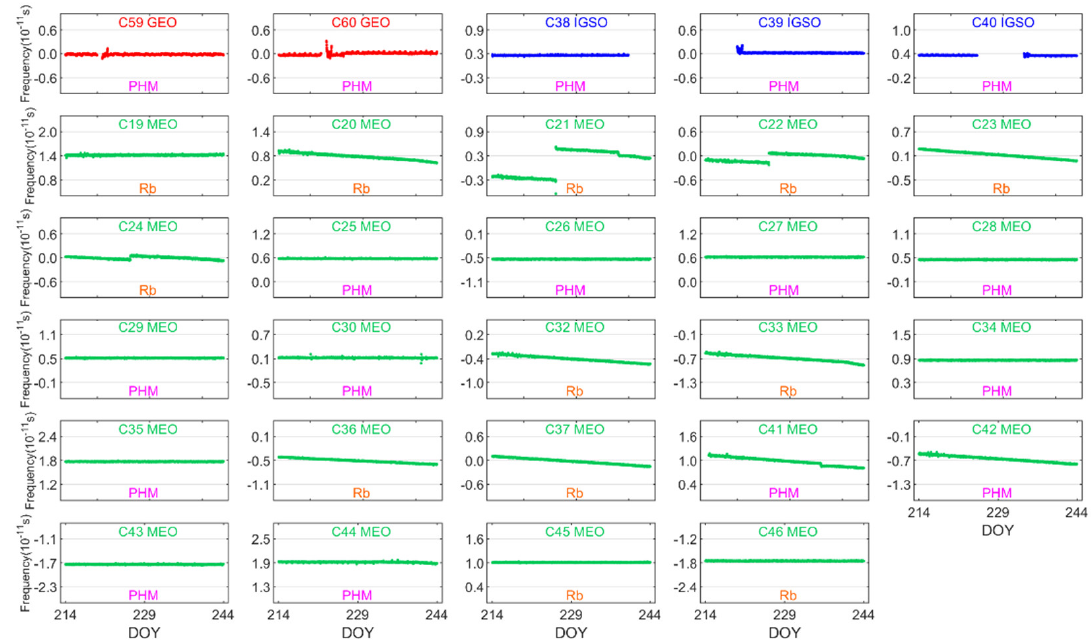
Figure 8. Frequency series of BDS-3 satellites.